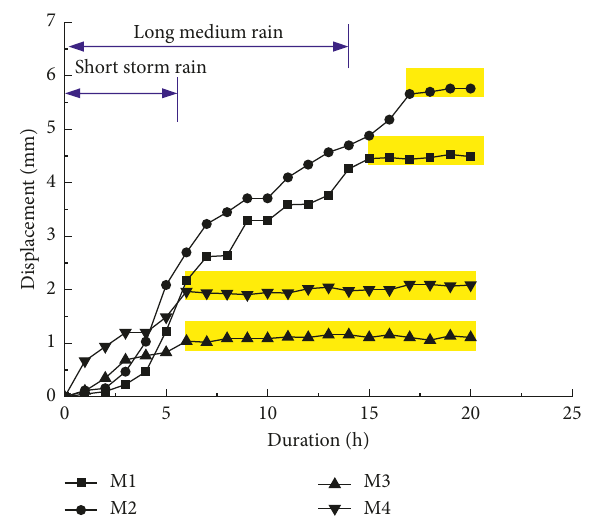
Figure 5: Displacement history at D1 point for four model slopes. The yellow zone is the stable